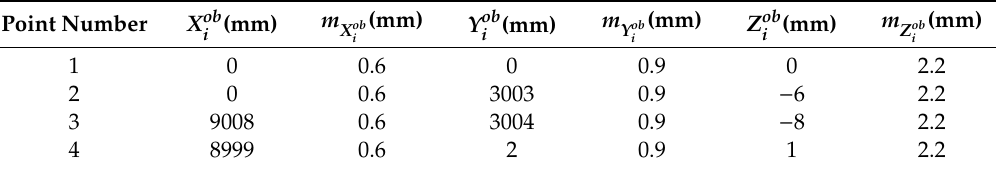
Table 4. Practical coordinates of points and their mean errors.